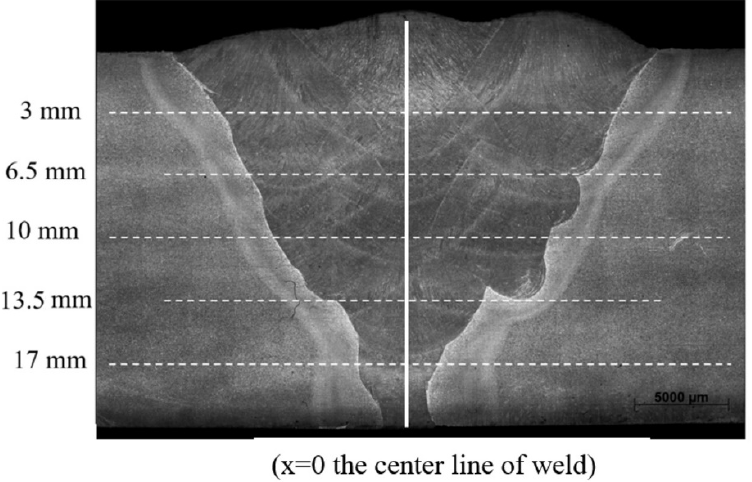
Figure 2. Optical macrograph of the weld joint showing the neutron diffraction stress measurement locations (dashed lines).